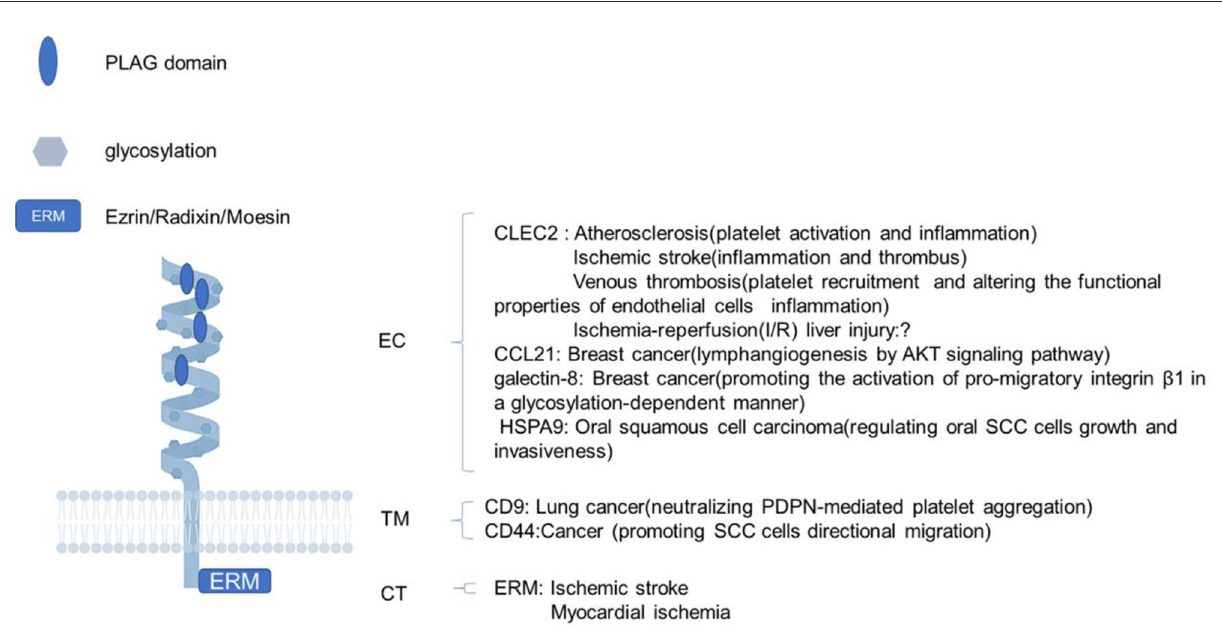
FIGURE1 The structure of podoplanin and its functions with interacting proteins. Schematic representation of the molecular structure of podoplanin with a heavily glycosylated extracellular domain, a single transmembrane domain, and a short 9-amino acid cytoplasm. The ligands and biological processes during which the identified molecules interacting with podoplanin are presented. EC, ectodomain; TM, transmembrane region; CT, cytosolic domain; PLAG, platelet